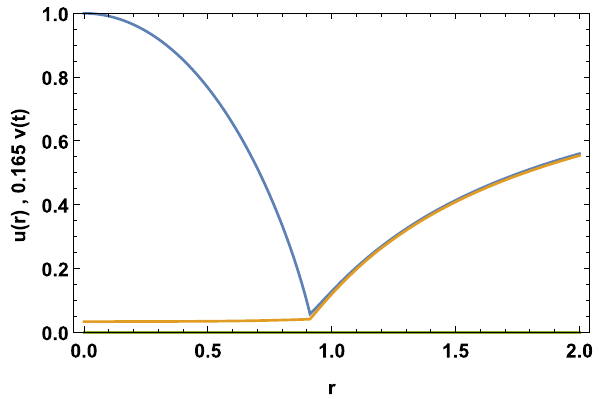
Fig. 6 Thetwometricfunctions.Asbefore, u ( r ) isthecurveapproach- ing the value of unity at the origin. The gravitational potential v( r ) in this case decreases towards the origin, and hence the gravitational pres- sure contributes to increasingly compressing the gas when approaching